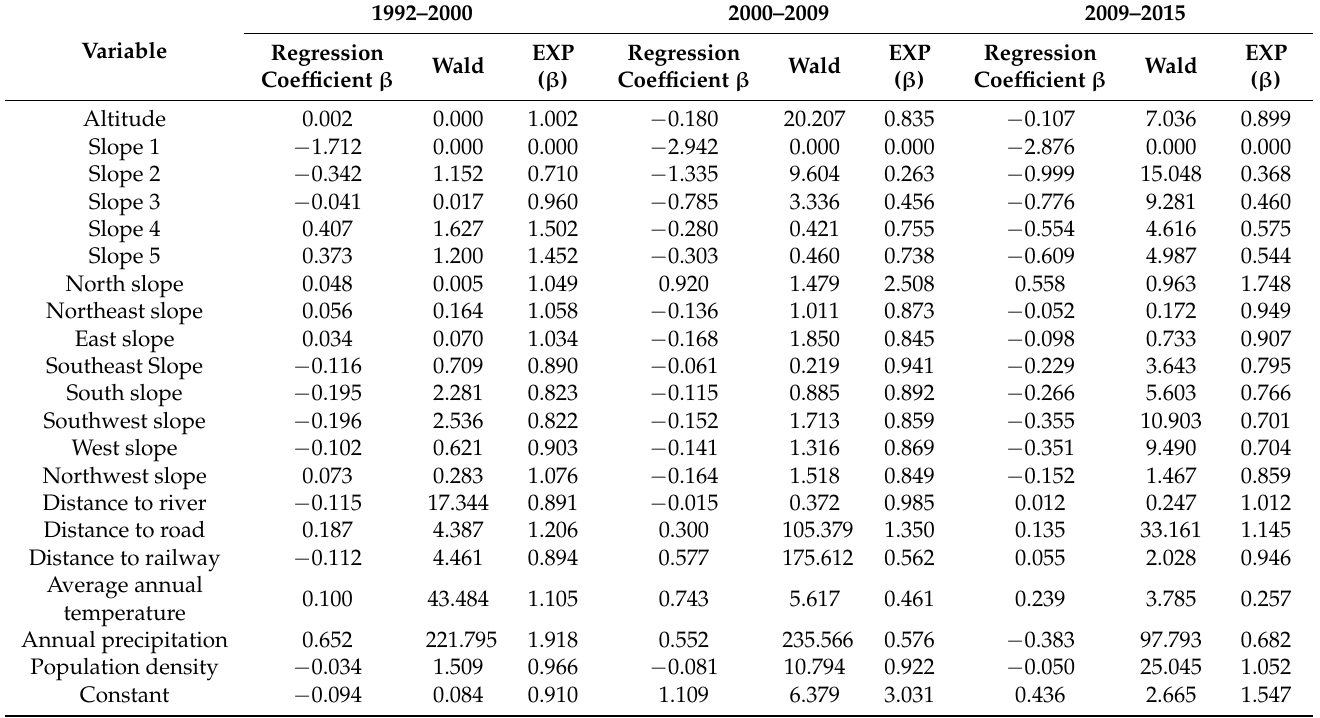
Table A5. Model estimates for Coniferous grassland expansion driving